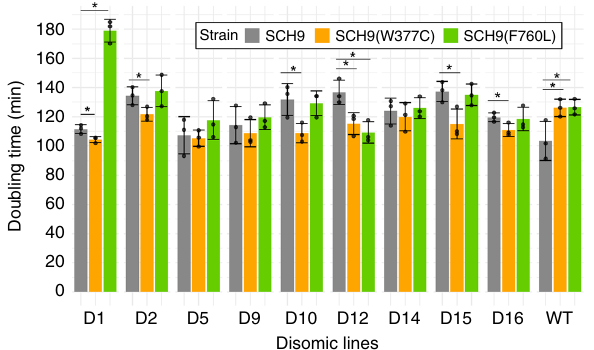
Fig. 6 Effect of SCH9 W377C and F760L mutations on cell growth. The effect of the SCH9 -W377C and SCH9 -F760L alleles on cell growth was analyzed with OD 600 measurement in triplicates. Disomic and WT strains were transformed with a linear PCR product of SCH9 (control, gray bars) or one of the mutated alleles (orange and green bars), fused with natMX6 marker (see Methods). Overnight cultures were diluted to 0.01 and growth was monitored for 2 days with BioTech Epoch2 plate reader. Error bars represent standard deviations. P-values for each condition were computed with two-sided t-test between each mutated allele and control and are supplied in Supplementary Data 3. Signi fi cant changes are marked with an asterisk (*). Source data for doubling times is provided in Supplementary Data